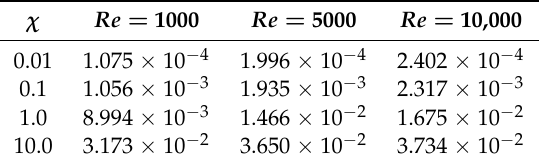
for the lid-driven cavity L 2 ([ 0,1 ] ; L 2 ( Ω ))